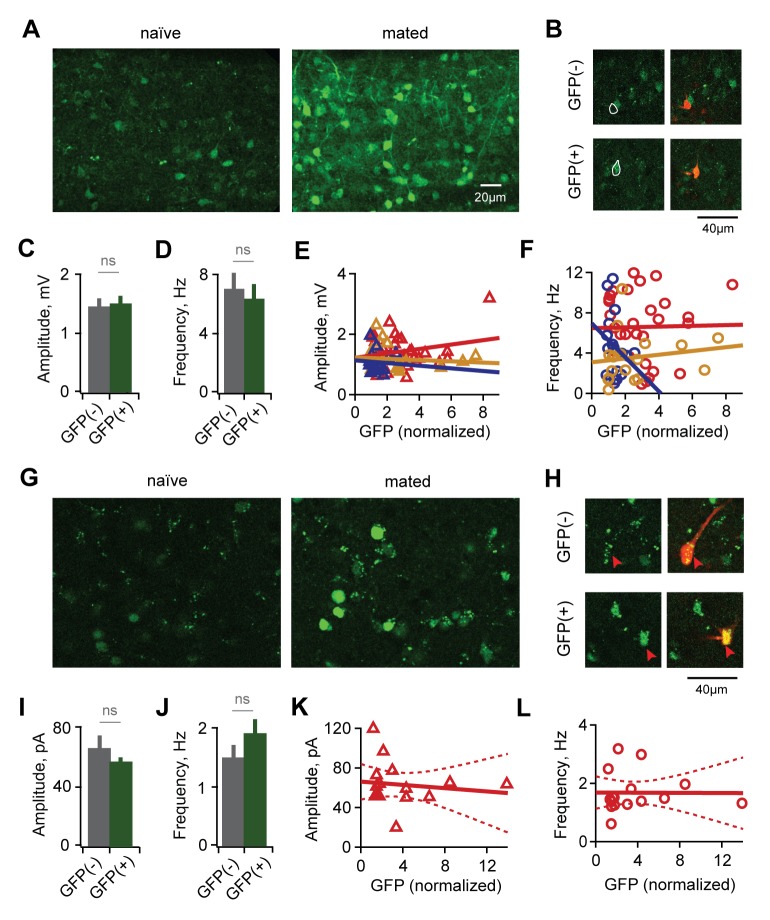
Synaptic plasticity is uncorrelated with activation during mating.(A) Arc-GFP labeling of AOB GCs activated by the stud male, visualized with live-tissue 2-photon imaging. Left, naïve control animal; right, mated female. (B) Fluorescence-targeted recordings of both unlabeled and labeled populations of GCs. (C,D) Mean amplitude and frequency of sEPSPs are similar for GFP(-) and GFP(+) GCs in mated mice (amplitude: p=0.82; frequency, p=0.58; t-test; n = 9 and 13 cells in 10 mice, GFP(+) and (-) groups subdivided from data in Figure 3—figure supplement 1). (E,F) GFP labeling is uncorrelated with either amplitude or frequency of spontaneous excitatory input to GCs (regression slope not different from zero; amplitude: p=0.70 and 0.22 for sensory-exposed and mated groups respectively; frequency: p=0.50 and 0.92; linear regression t-test; n = 17, 19 and 30 neurons in 5, 9, and 12 mice for naïve, exposure and mated groups). (G) Fos-GFP labeling reveals a subpopulation of mating-activated MCs (arrowheads). (H) Targeted recordings of stud-activated MCs. (I,J) Mean amplitude and frequency of mIPSCs are not significantly different between GFP(-) and GFP(+) MC populations (p=0.33 and 0.38 respectively; t-test; n = 8 and 5 cells in 5 mice; groups subdivided from data in Figure 2). (K,L) Amplitude and frequency of mIPSCs show no correlation with Fos-GFP intensity in MCs (regression slope not different from zero; p=0.64 and 0.97 respectively; linear regression t-test; n = 16 neurons from 5 mice). Dashed lines show 95% confidence intervals.DOI:
http://dx.doi.org/10.7554/eLife.25421.01110.7554/eLife.25421.012Figure 3—source data 1.This spreadsheet contains the mean frequency and amplitude data for the individual neurons used to generate the bar plots shown in Figures 3C, D, I and J, comparing synaptic inputs to GFP(-) and GFP(+) neurons.These data can be opened with Microsoft Excel or with open-source alternatives such as OpenOffice.